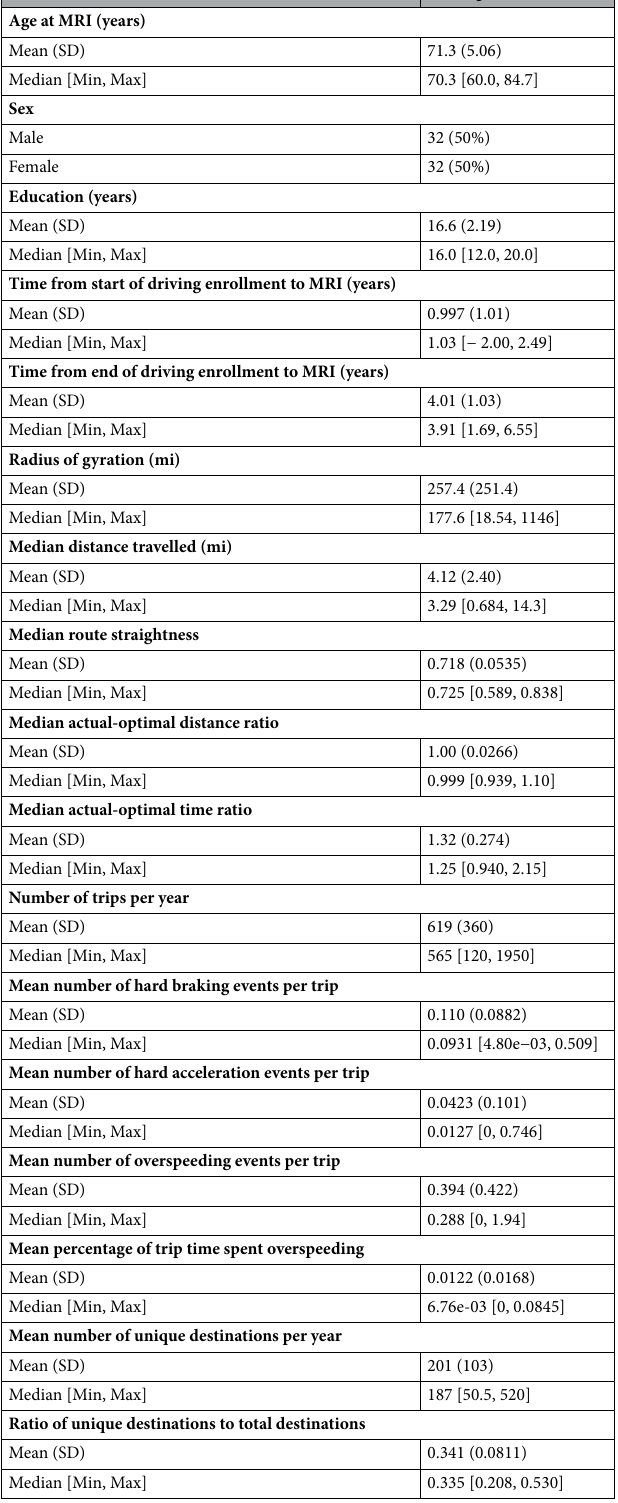
Table 1. Participant Demographic